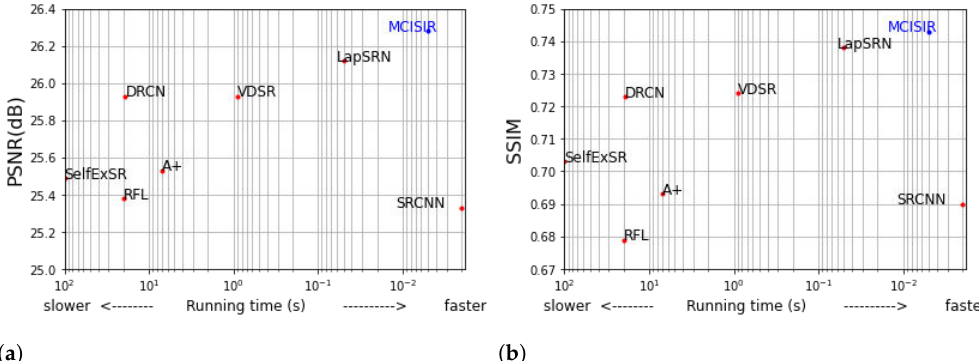
Figure 10. Performance comparisons in terms of execution time versus PSNR ( a )/SSIM ( b ) on SET5 dataset with enlargement scale factor 8 ×